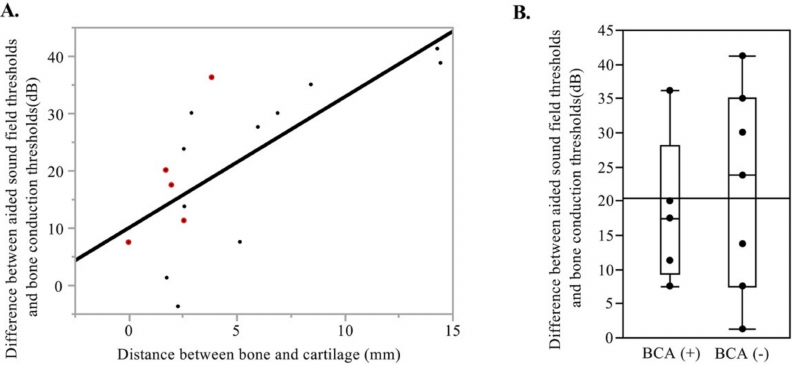
Figure 3. Effectiveness of the cartilage conduction hearing aid in cases after lateral temporal bone resection. ( A ) The relationship defining the distance between the auricular cartilage and the temporal bone and the difference between the aided sound field and bone conduction thresholds in 16 cases with the cartilage conduction hearing aids. Red dots show cases with BCA. ( B ) Difference between the aided sound field and bone conduction thresholds in 12 cases without external auditory meatus reconstruction. BCA; bone-cartilage anchoring.